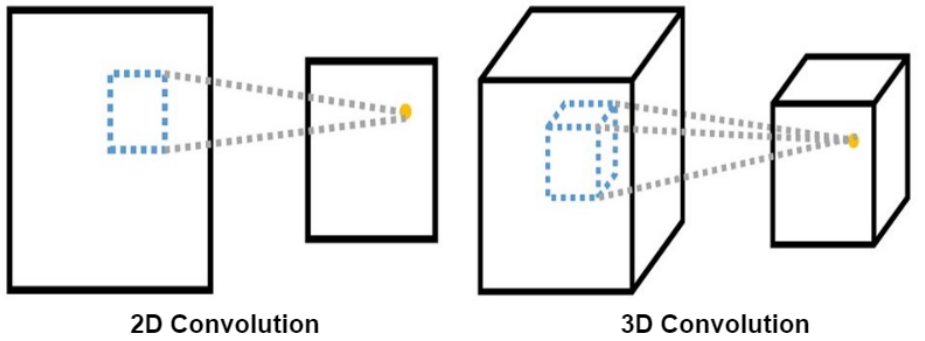
Figure 6. 2D vs. 3D convolution.